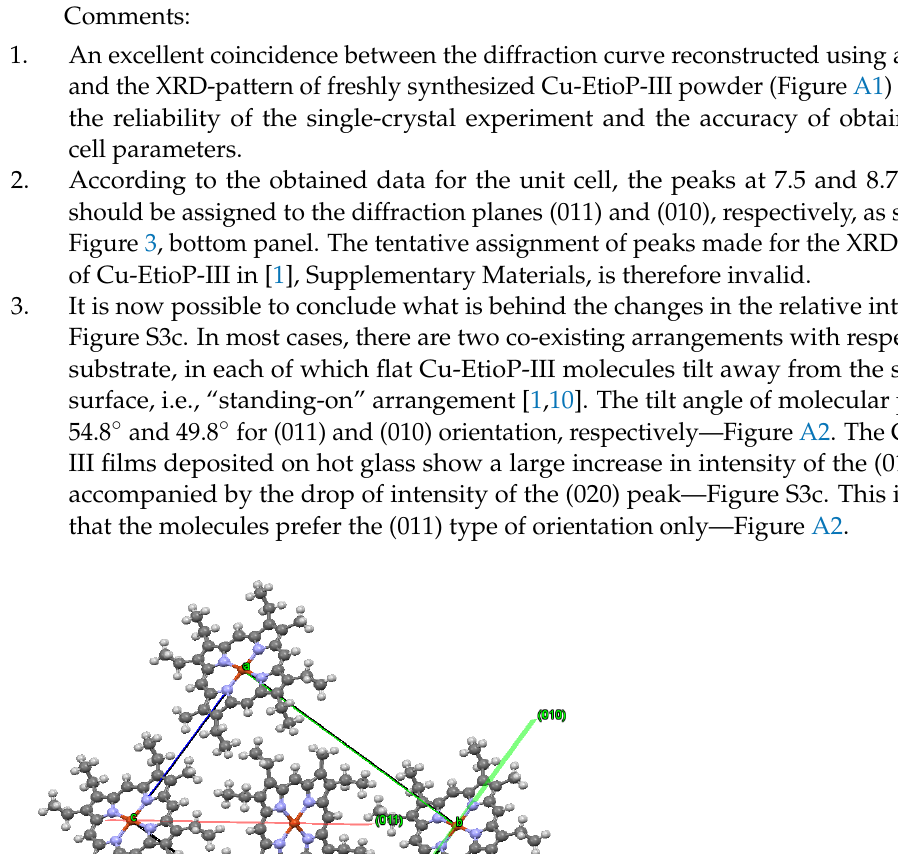
Figure A1. Comparison of experimental powder diffraction pattern of Cu-EtioP-III, green curve (from [1]) and simulated XRD-pattern, black curve (tuned cell).